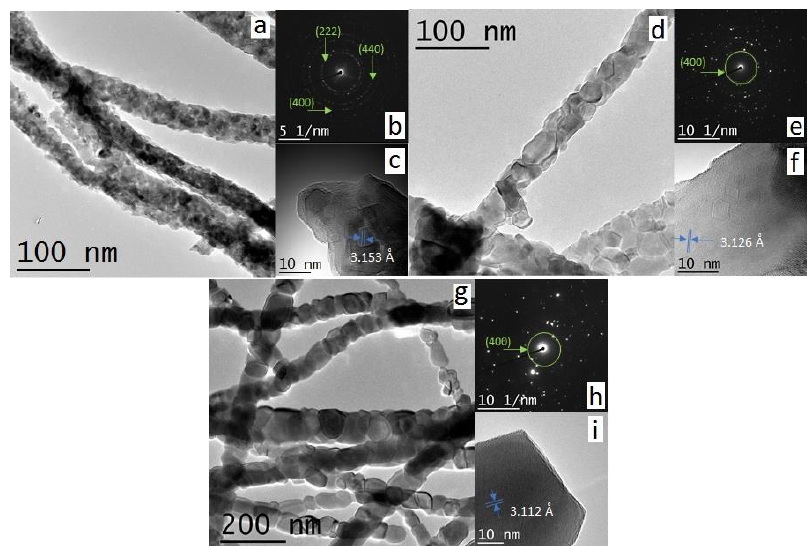
Figure 3. TEM, SAED and HR-TEM images of ( a ), ( b ), ( c ) CGO600, ( d ), ( e ), ( f ) CGO700, and ( g ), ( h ), Figure 3. TEM,SAEDandHR-TEMimagesof( a – c )CGO600, ( d – f )CGO700, and( g – i )CGO900,respectively. ( i ) CGO900, respectively.